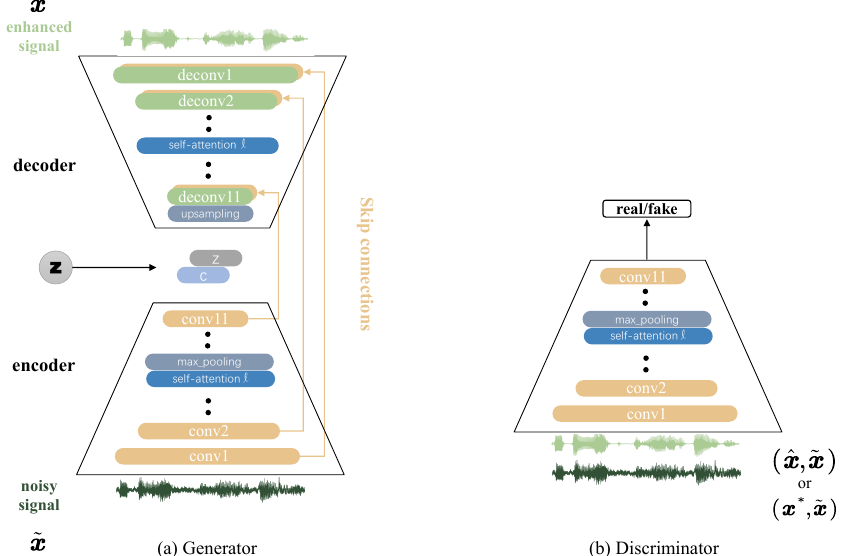
Figure 3. Illustration of the architecture of speech enhancement GAN (SEGAN) with stand-alone self-attention layers. ( a ) The generator component. ( b ) The discriminator